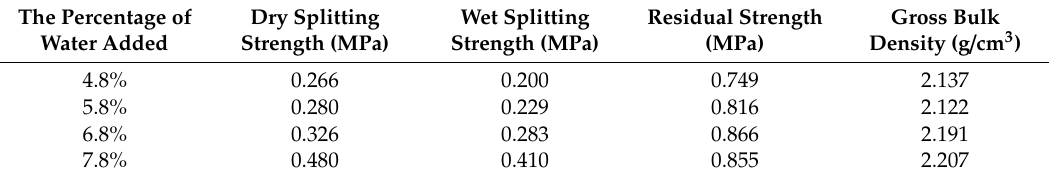
Table 6. Performance of specimens with di ff erent moisture contents.